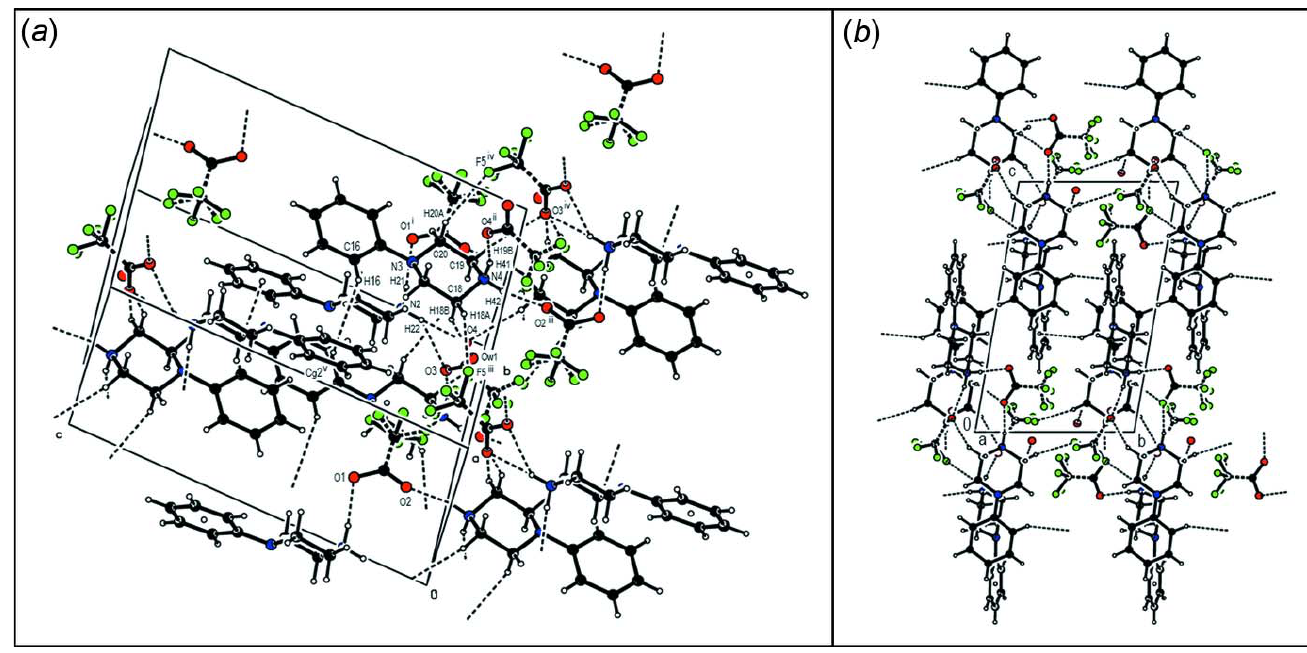
Figure 8 Parts of the crystal structure of compound ( IV ) showing ( a ) a general view of the C—H (cid:2)(cid:2)(cid:2) O, N—H (cid:2)(cid:2)(cid:2) O and C—H (cid:2)(cid:2)(cid:2) F hydrogen bonds and C—H (cid:2)(cid:2)(cid:2) (cid:2) interactions and ( b ) the molecular packing of ( IV ) down the a -axis. Hydrogen bonds and C—H (cid:2)(cid:2)(cid:2) (cid:2) interactions are drawn as dashed